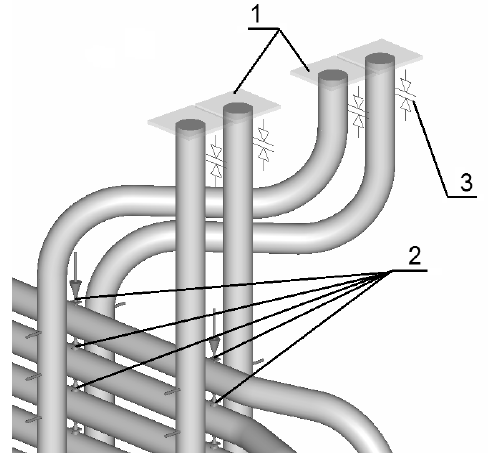
Figure 3. Method of superheater SH3 support: 1—Anchor, 2—Guide, 3—Cut Short.